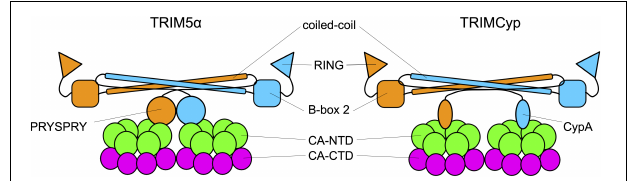
FIGURE 3 | Interaction between TRIM and the capsid. TRIM5 α and TRIMCyp are represented in their dimeric form. Each monomer (in orange and in blue) is formed by the RING domain, the B-Box 2 domain, the coiled-coil domain and the C-terminal domain which is the one responsible for the interaction with the capsid core. In TRIM5 α this domain is the PRYSPRY domain while in TRIMCyp is